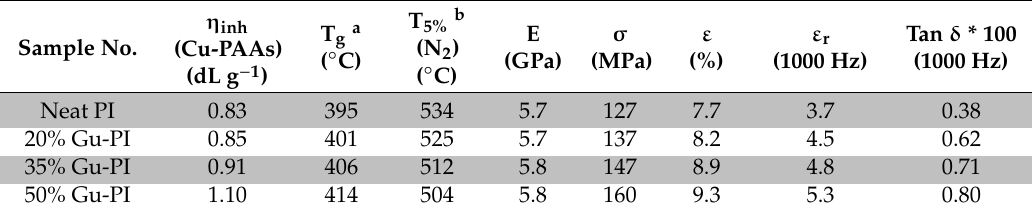
Table 1. Properties of neat PI and Cu-PI